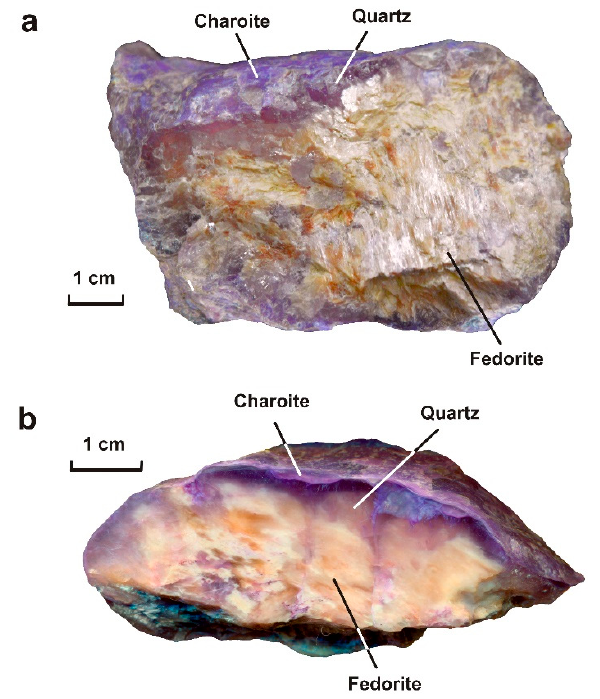
Figure 3. SampleYak-5withfedoritefromtheYakutskiydistrict: ( a )unpolishedsample, ( b Figure 3. Sample Yak-5 with fedorite from the Yakutskiy district: ( a ) unpolished sample, ( b ) polished sample.